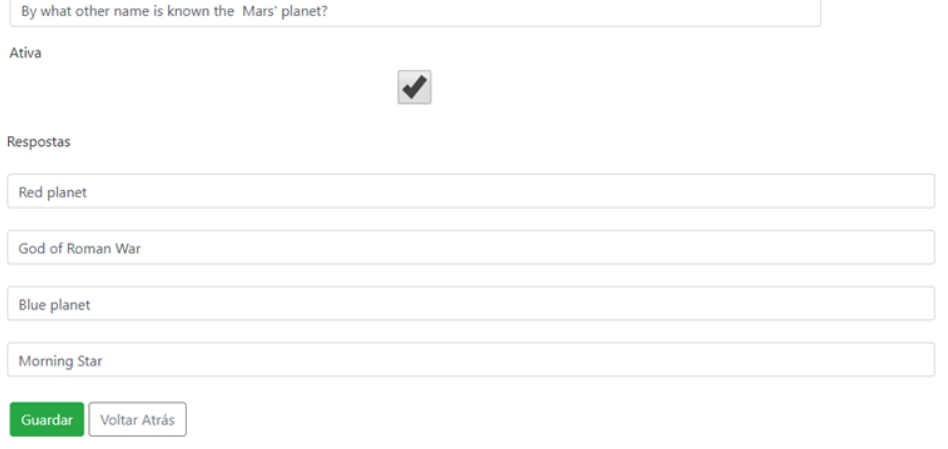
Figure 16. Example of a webpage with a question about